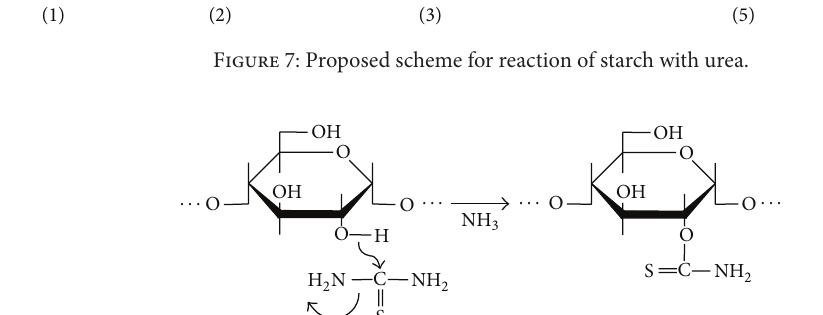
Figure 8: Proposed scheme for reaction of starch with